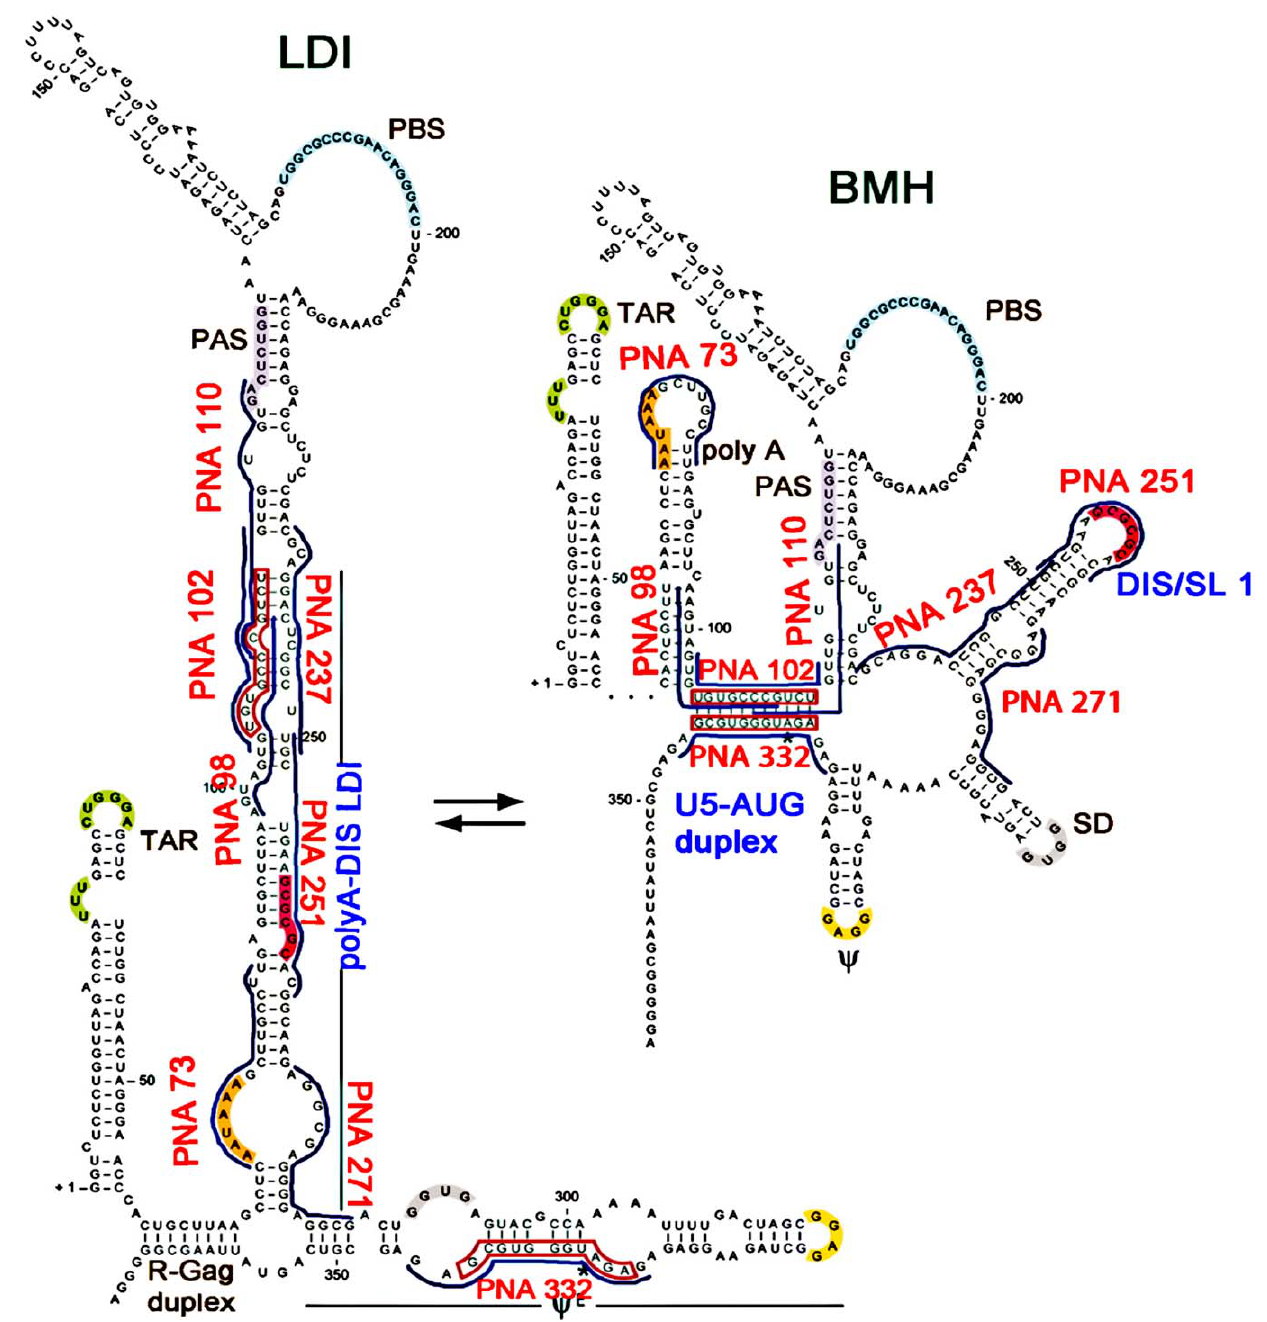
Figure 1. Proposed stem-loop structure of the 5 9 untranslated region of HIV-1. Target loop regions are highlighted. PNAs targeted against different sites of 5 9 UTR of HIV-1 are shown in the diagram (Abbink et. al. 2003).